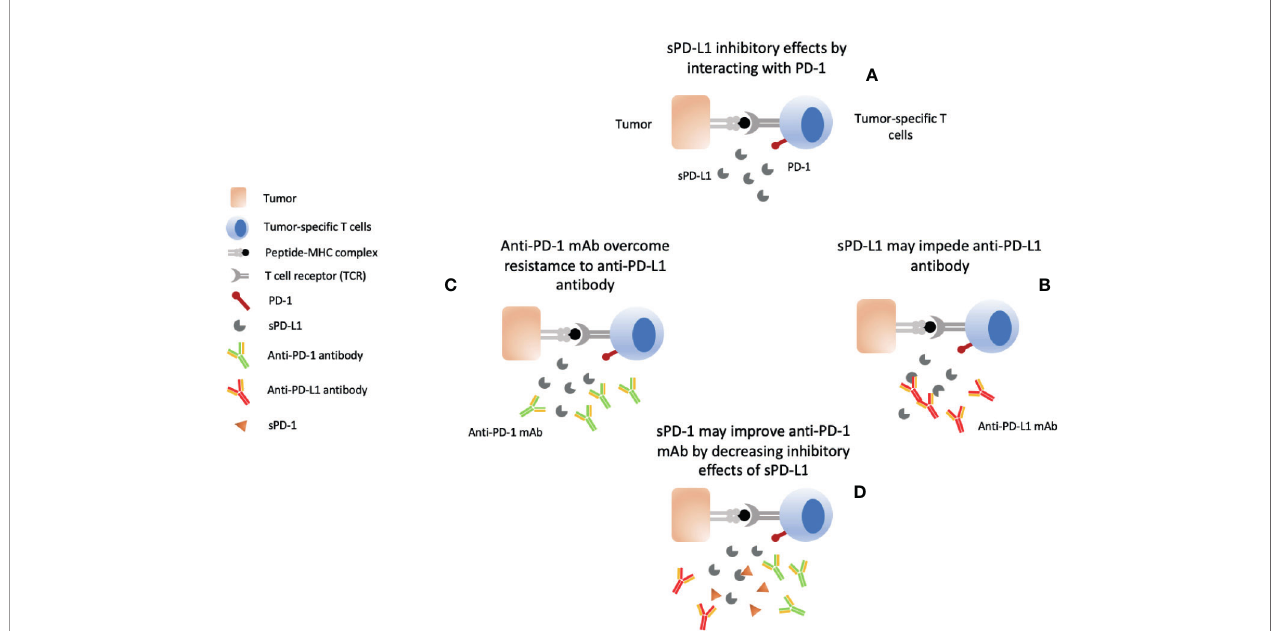
FIGURE 4 | Soluble PD-L1 and Anti-PD-1/PD-L1 mAb immunotherapy conundrum. (A) Elevated circulating sPD-L1 in various cancers correlates with prognosis and exerts its inhibitory effects on tumor-speci fi c T cells by interacting with PD-1 receptor. (B) sPD-L1 impedes ef fi cacy of anti-PD-L1 antibodies. (C) Anti-PD-1 may overcome resistance to anti-PD-L1 antibodies by reducing interaction between sPD-L1 and PD-1 (D) sPD-1 may overcome sPD-L1-mediated resistance to anti-PD- L1 antibody by directly interaction with sPD-L1 and mPD-L1. Anti-PD-1 antibody addition may result in a stronger